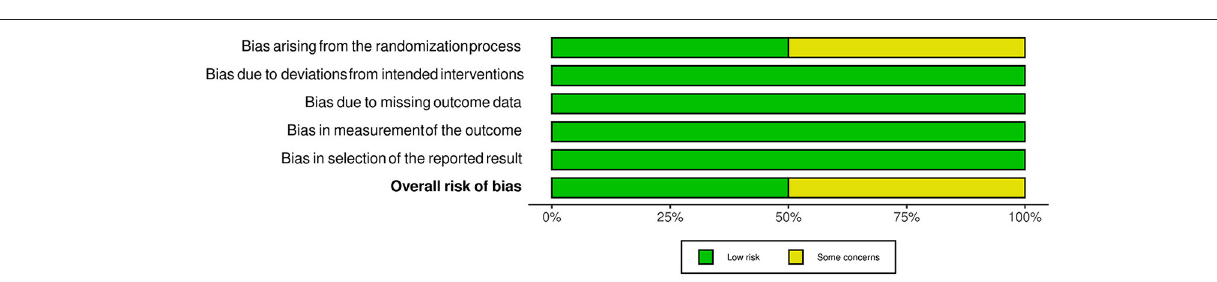
FIGURE 2 | Risk of bias for randomized control trials.